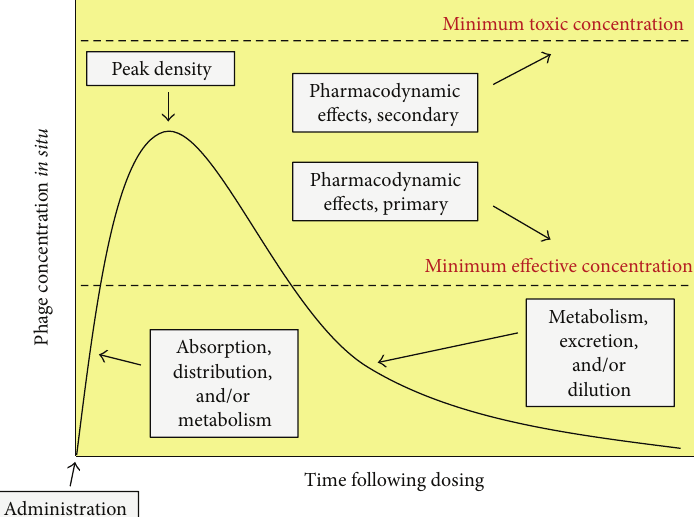
Figure 4: Basics of phage therapy pharmacology. Absorption and distribution can have the effect of increasing antibacterial concentrations within the vicinity of target bacteria, though also they have a diluting effect on dosages. Phage infection too can increase phage numbers within the vicinity of target bacteria, which I have indicated as being an aspect of metabolism and which more generally is a description of the chemical modification of a drug. Together these pharmacokinetic mechanisms contribute to some peak phage density that may or may not be sufficient to substantially decrease densities of target bacteria [93, 117]. Particularly, peak densities must exceed some minimum effective concentration to effect net reductions in bacterial densities and these densities can be achieved through a combination of supplying sufficient phage numbers per individual dose, supplying multiple doses, and/or allowing for phages to replicate in situ . Ideally phage densities will not be so high that toxicity results. Exactly what phage densities are necessary to achieve toxicities is not well appreciated, except that impurities in phage formulations can contribute to such toxicities (as too can potentially the humoral immune system given nonnaive patients). As a consequence of this uncertainty, what constitutes a preferred upper limit of phage densities is not known in the same way that minimum toxic concentrations can be appreciated for specific small-molecule drugs, except that this upper limit may be high relative to minimum effective phage densities. Lastly, various mechanisms exist whereby phage densities may decrease over time, which include what pharmacologically are described as metabolism and excretion, though as noted dosage dilution plays a role as well. A modified version of this figure is found in Abedon [93] as